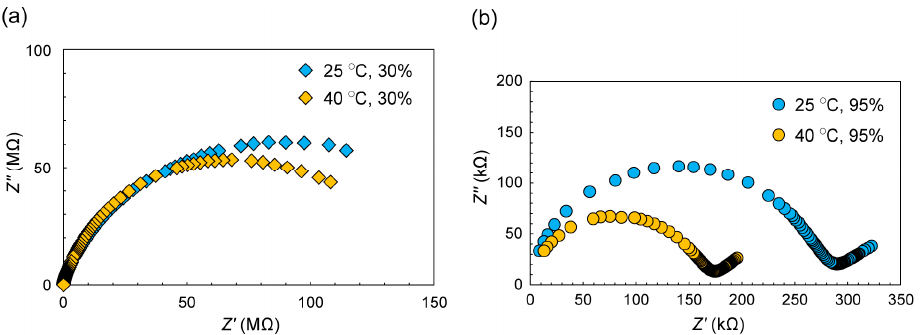
Figure 5. Nyquist spectra of C 12 N 2 -H 2 W 12 hybrid crystals: ( a ) measured under a low-humidified condition (30% RH) and ( b ) measured under a high-humidified condition (95% RH).